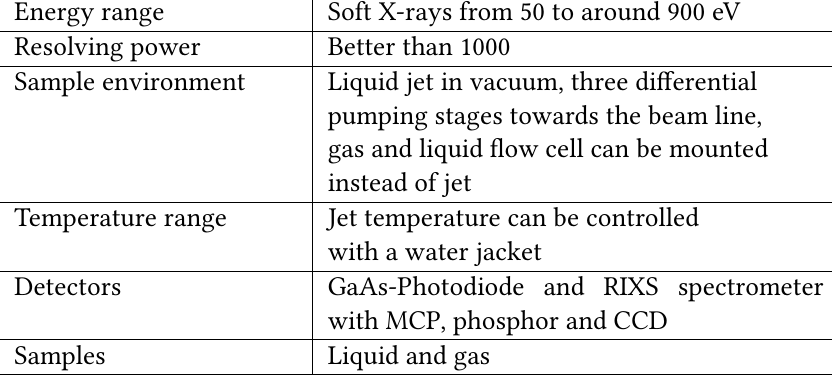
Table 1: Technical parameters of the Liquid flexRIXS end